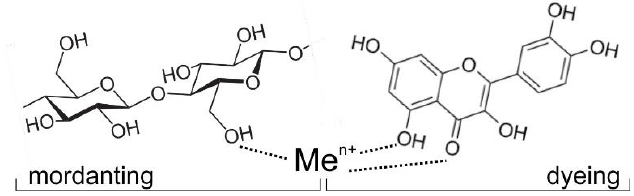
Figure 3. Schematic image of ligand formation: fibre — metal ion — natural dye. After dyeing, the samples were spectrophotometrically measured, and the analysis of objective colour parameters was performed. The results of the coordinate placement of the obtained colours are shown in a*/b* colour space, with a graphical representation of the objective values of the basic colour parameters: lightness (L*), chroma (C*) and hue (h ◦ ), in Figure